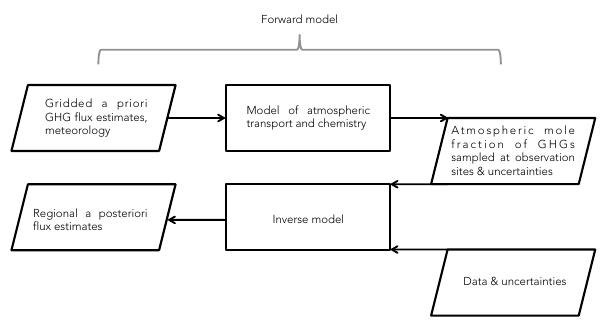
Figure 8. Schematic of the generalized GAUGE modelling strategy. The diagram neglects the non-linear inverse modelling